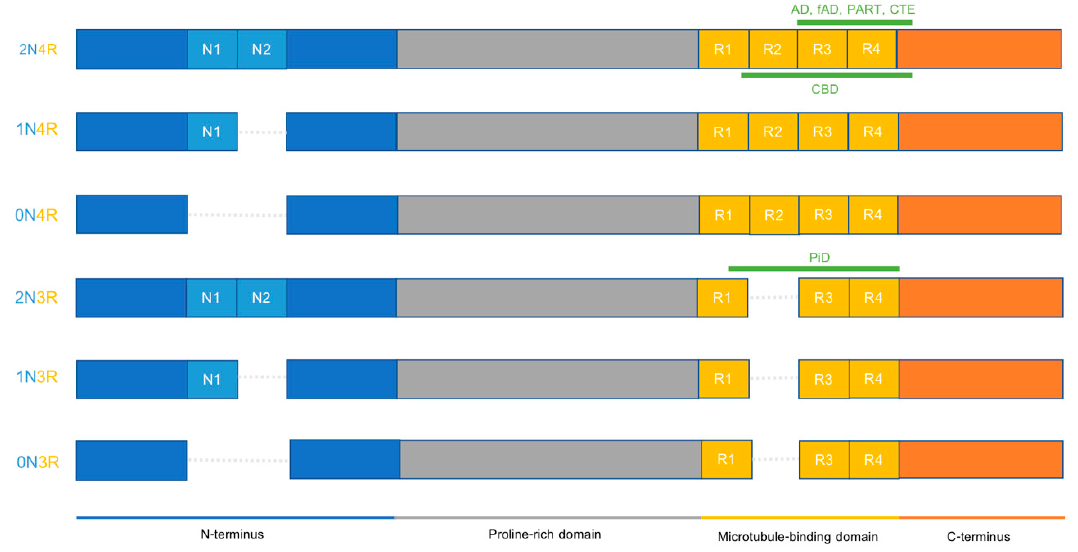
Figure 1. Tau isoforms in the adult human CNS and their relation to disease-specific tau fibrils. Tau filaments from distinct tauopathies exhibit different structural features. AD, fAD, and PART have identical cores spanning amino acids 306 to 378 that can incorporate all six tau isoforms (tau core was only indicated on the 2N4R isoform but applies to all six isoforms). These filament cores include repeats 3 and 4 and a portion of the C-terminus. The CTE core has some similarity to the AD core in terms of incorporated regions (R3 and R4) but is structurally distinct and is located between amino acids 305 to 379. CBD tau fibrils have a core that spans R1 until 12 residues after R4 and can only include 4R isoforms (tau core was only indicated on the 2N4R isoform but applies to all three 4R isoforms). CTE cores include amino acids 274 to 380. PiD tau fibrils have a core that spans R1 to R4 of 3R tau isoforms, between amino acids 254 and 378 (tau core was only indicated on the 2N3R isoform but applies to all three 3R isoforms). This core excludes R2, explaining why this is a 3R tauopathy.